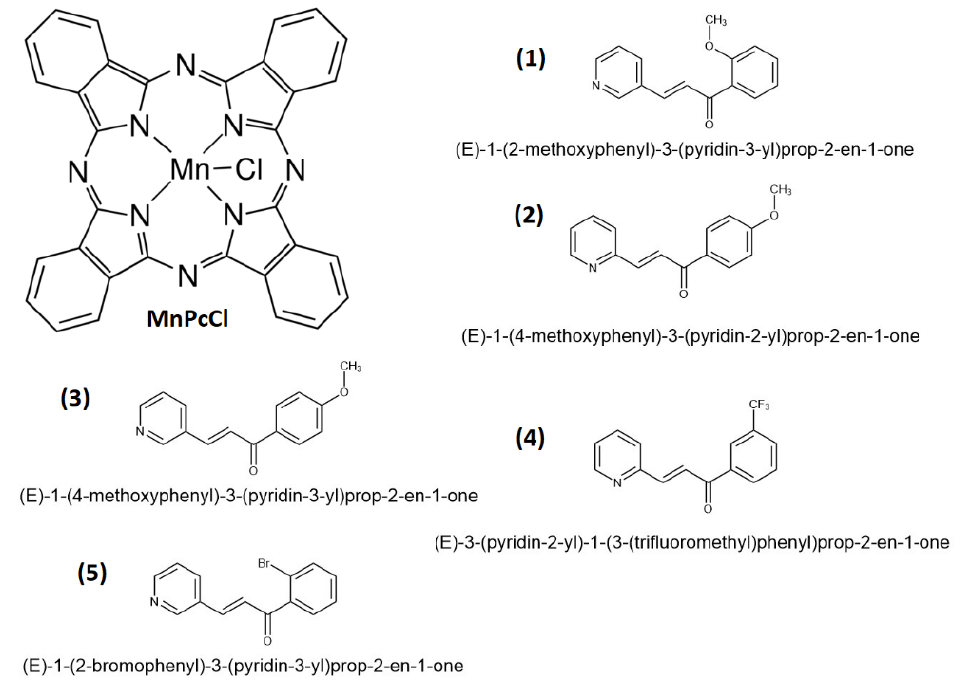
Figure 1. Structure of MnPcCl and chalcones.